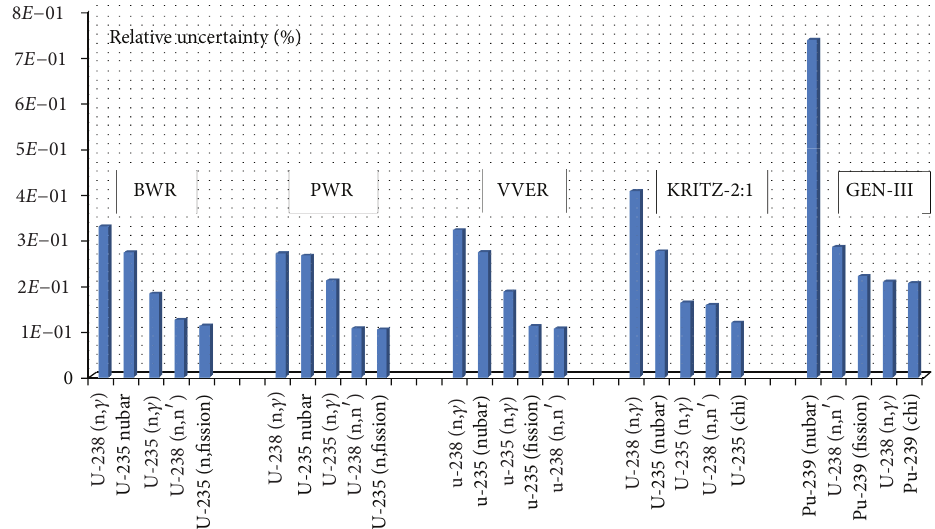
Figure 4: The five reaction cross-sections with the highest contribution to the −0.15−0.1−0.0500.050.10.150.20.25